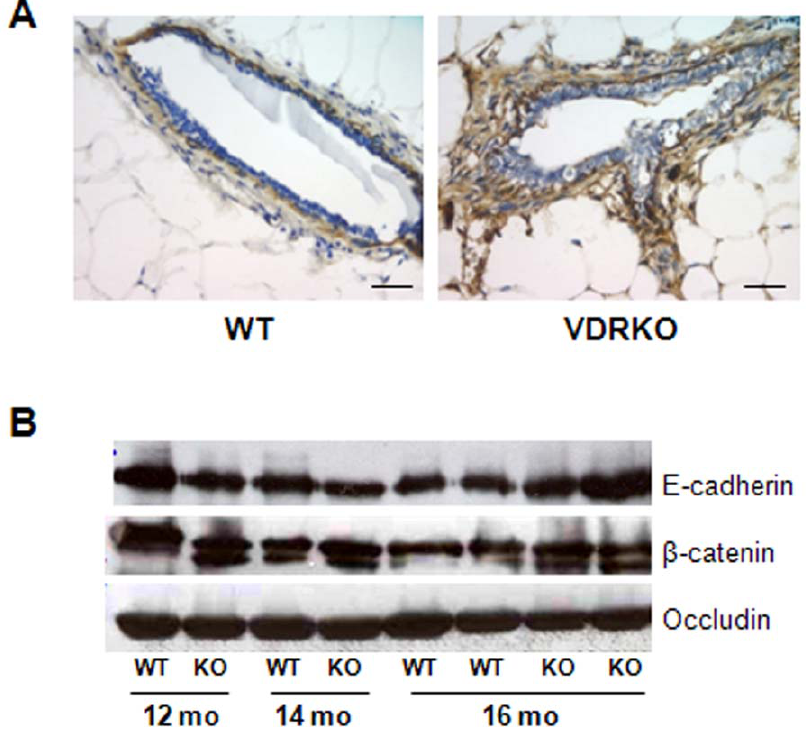
Figure 3. Stromal smooth muscle actin and cell junction expression in glands from WT and VDR KO mice. A. Elevated level of smooth muscle actin staining in VDR KO glands compared to VDR WT control sections. SMA positive cells appear brown against the blue hematoxylin counterstain. B. Western blot for cell junction markers E-cadherin, b -catenin, and occludin to assess changes in the epithelial cell junctions that may account for the increase in secretion within the VDR KO ducts. E-cadherin, b -catenin, and occludin expression were equivalent at all time points during aging development between VDR WT and KO mammary glands.